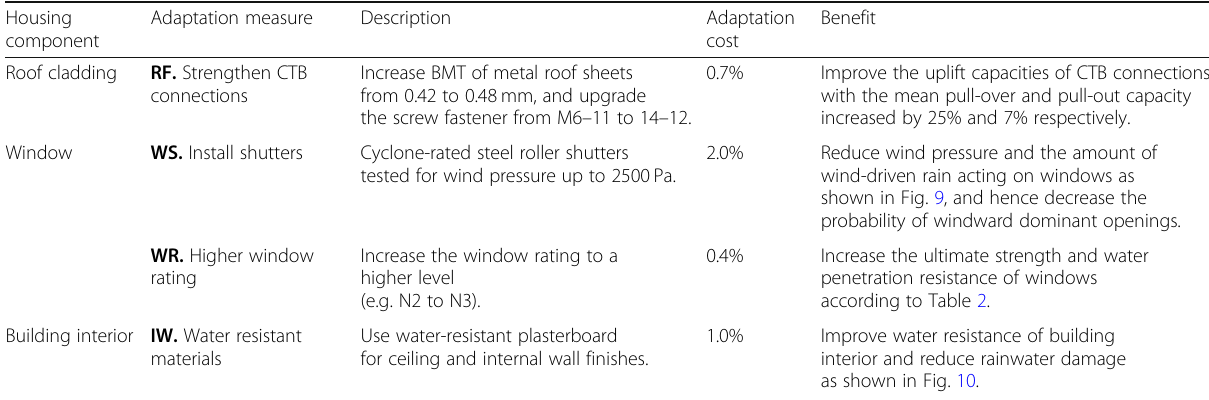
Table 6 Climate adaptation measures for contemporary housing Housing